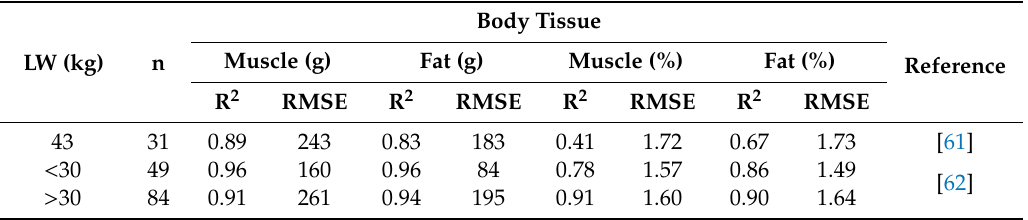
Table 4. Values of coe ffi cient of determination and residual mean square error of regression models to predict in vivo the amount and percentage of body muscle and fat from MRI in sheep. Body LW (kg) n